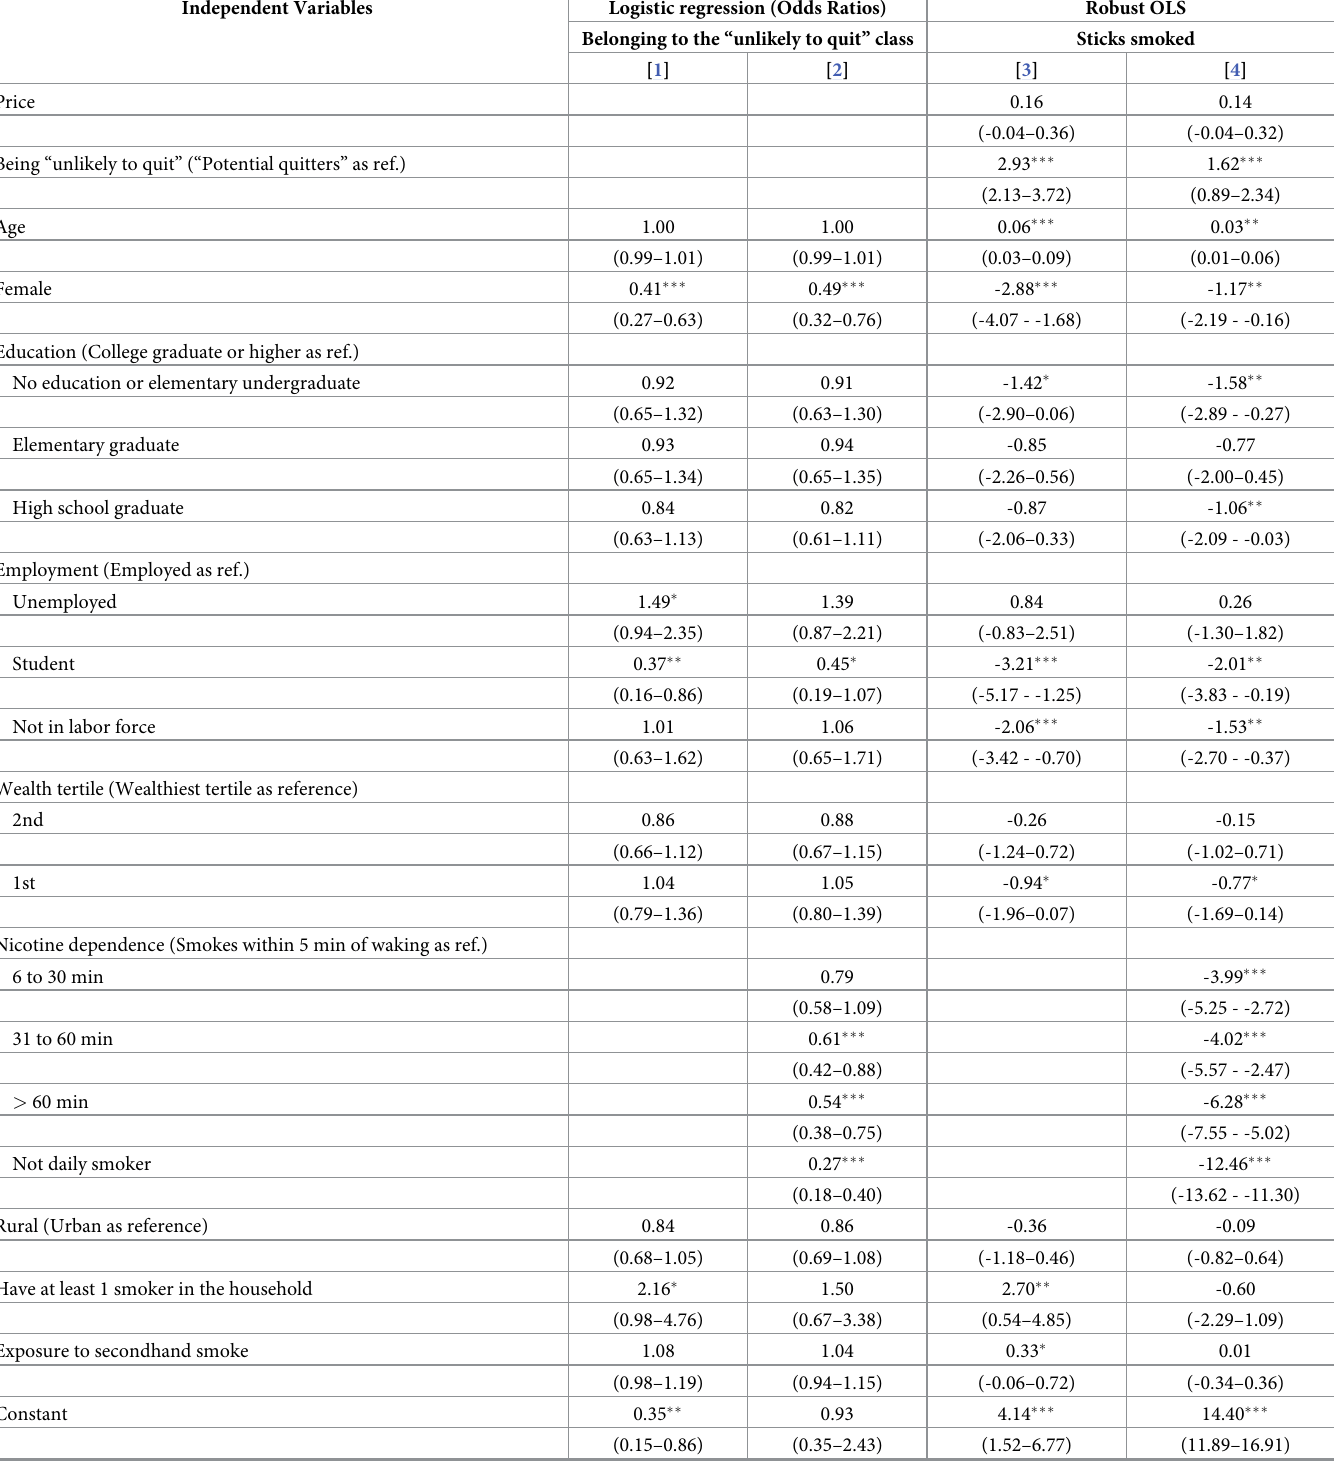
Table 3. Regression